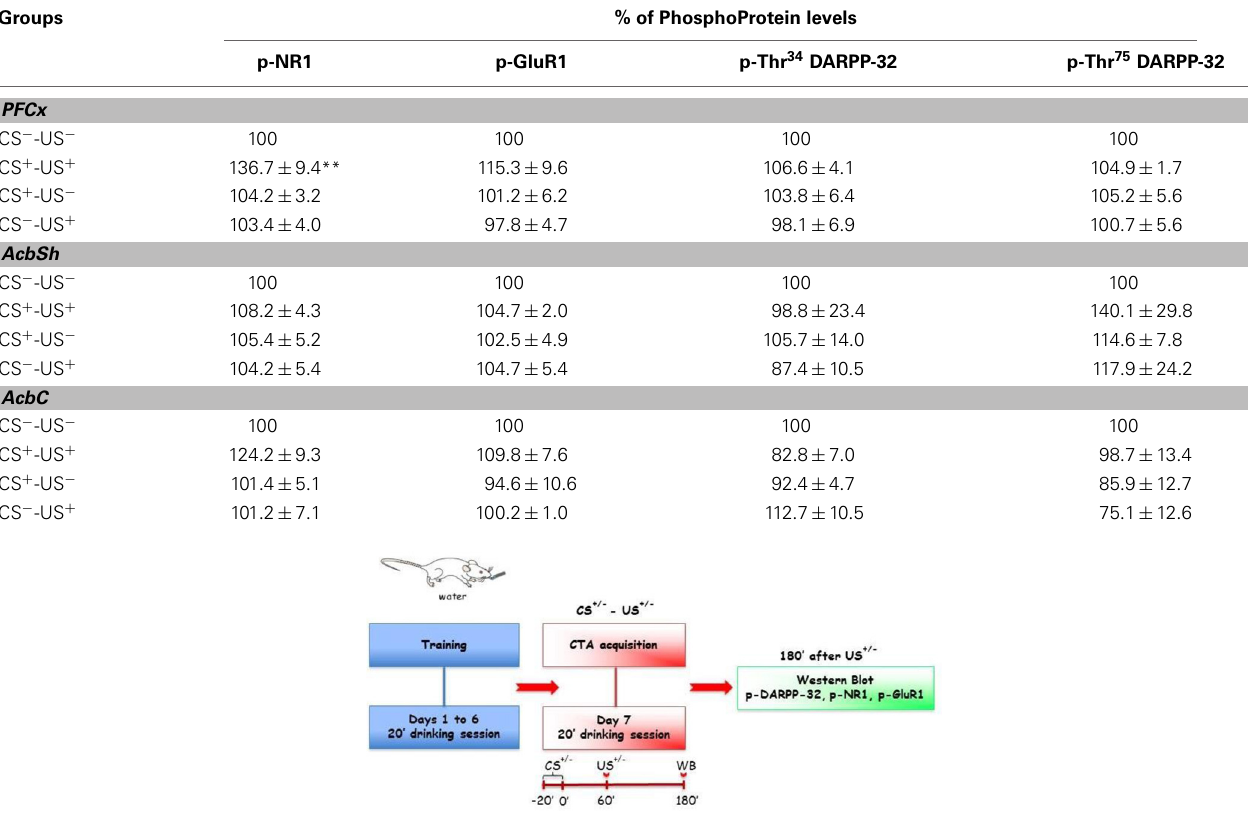
Table 2 | Levels of p-NR1, p-GluR1 p-Thr 34 and p-Thr 75 DARPP-32, in different brain regions after CTA acquisition.